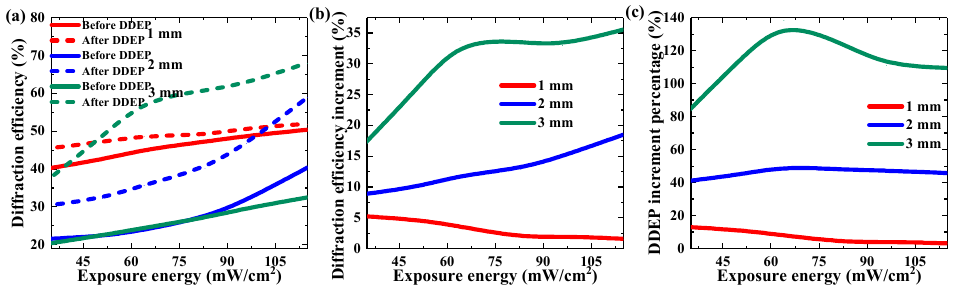
Figure 4. Effect of exposure energy on DDEP of materials with different thickness: ( a ) maximum diffraction efficiency, ( b ) diffraction efficiency increment, ( c ) DDEP increment percentage.